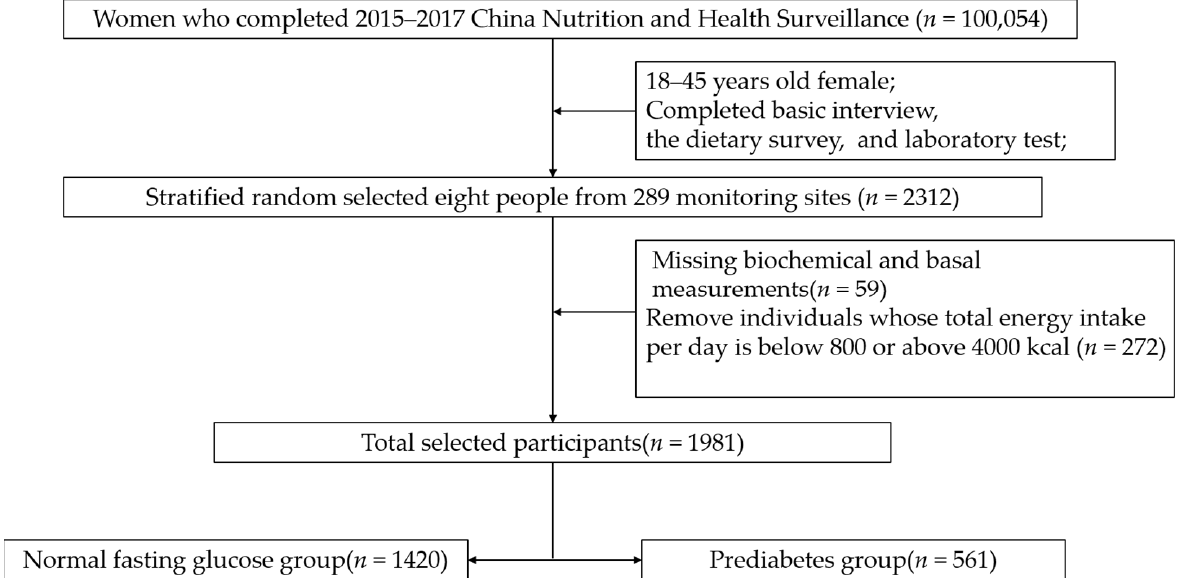
Figure 1. The flowchart of the selection of cases and controls.